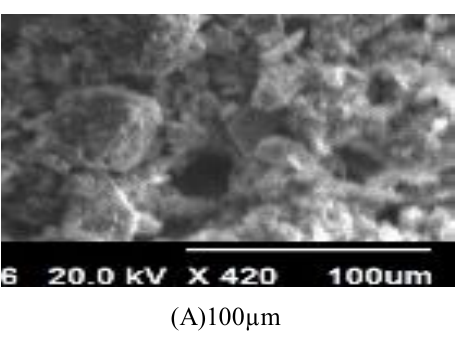
(Figure5 A, B, C): SEM of nano HA coating at different magnifications.